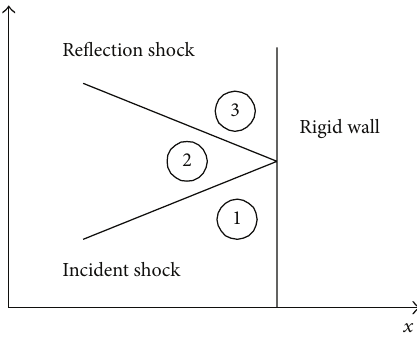
Figure 5: Schematics of reflection